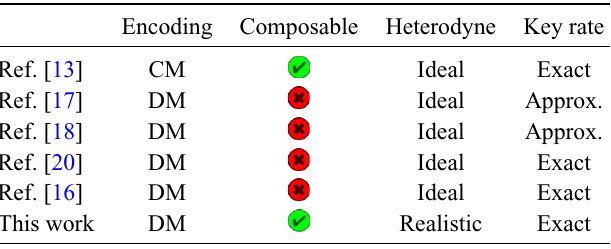
TABLE I. A comparison of our results with previous security analyses of CV QKD. We only include works that have pro- vided a tight estimate of the key rates. Encoding: the protocol considered has continuous (CM) or discrete (DM) modulation. Composable: the security analysis is in the framework of com- posable security. Heterodyne: the security analysis assumes an ideal or realistic model for heterodyne detection. Key rate: the estimation of the key rate is exact or obtained through numerical